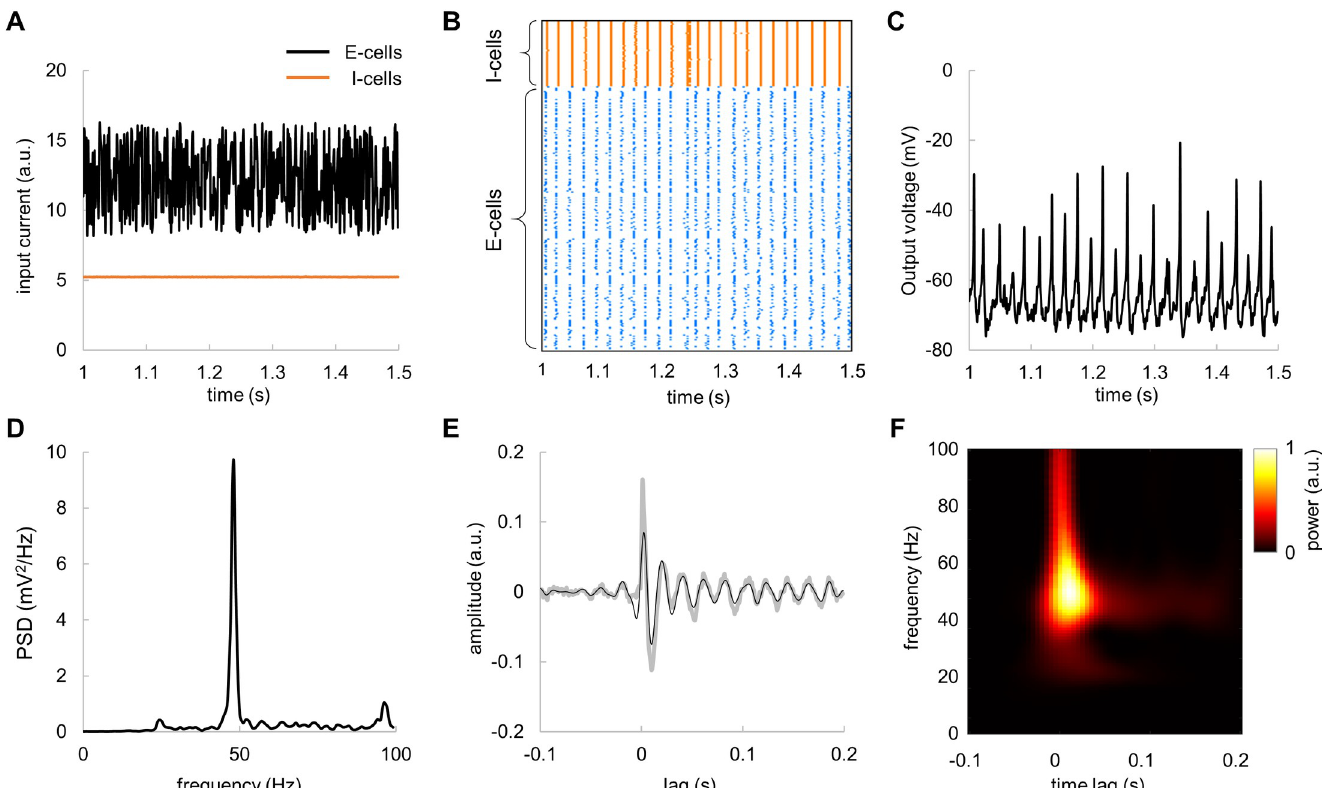
Fig 8. Broadband input current to E-cells produces damped oscillations in the TRF–the gamma echo. (A) Broadband input current to E-cells (black line) and constant input current to I-cells (orange line). (B) Spike rastergram for E-cells and I-cells for broadband input current. (C) The average membrane potential of the E- cells in response to fluctuating input currents. (D) Power spectral density of average membrane potentials of the E-cells averaged over 20 trials. (E) TRF assessed for the average membrane potentials of the E-cells with respect to the broadband input current. Note the clear “gamma echo”. Gray and black lines depict respectively raw and the filtered TRF (40–100 Hz) averaged over 20 trials. (F) Time-frequency representation of power of the TRF.